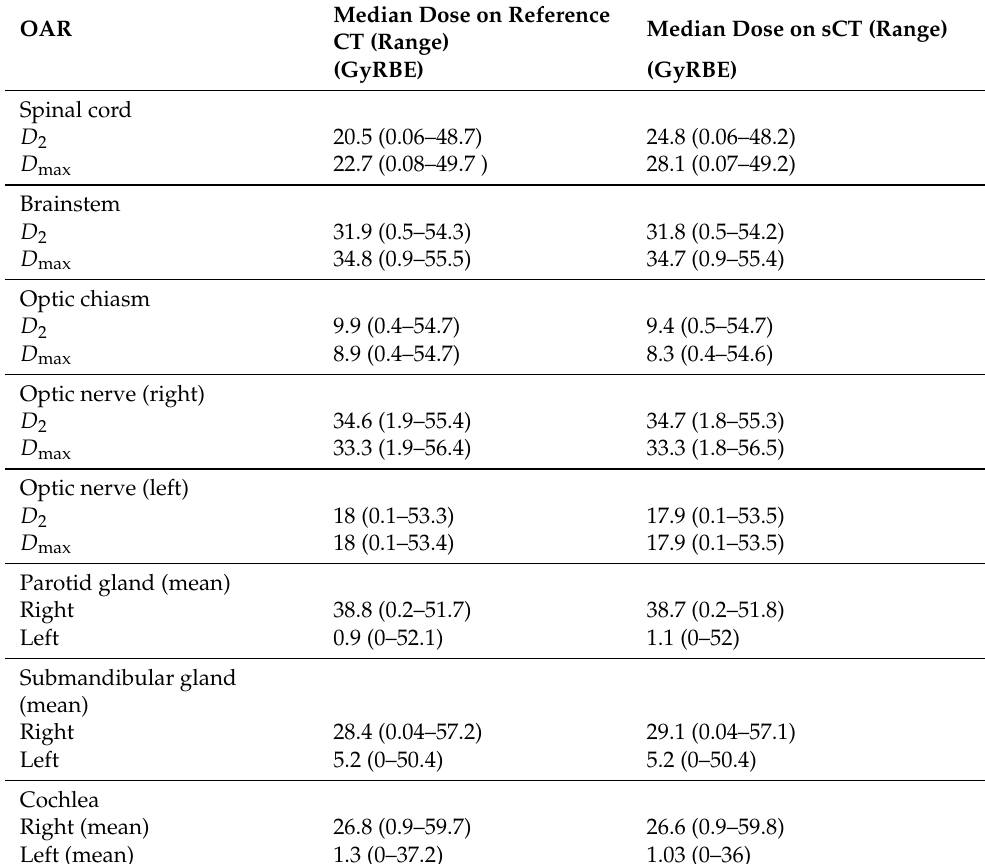
Table 3. Therapeutic dose received by various organs-at-risk (OARs) on reference CT and synthetic CT created from the verification